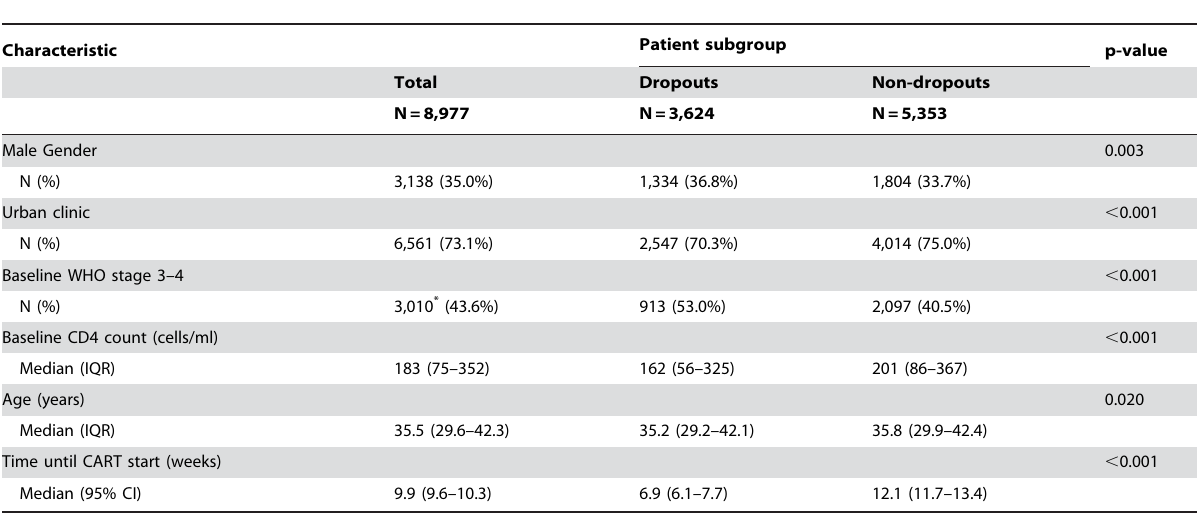
Table 1. Patient characteristics and comparison between dropouts and